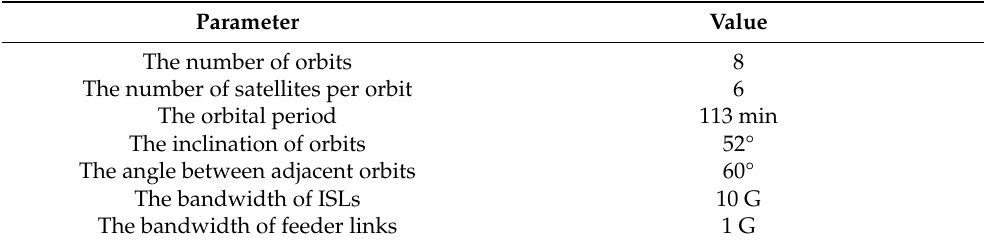
Table 1. Parameters of the